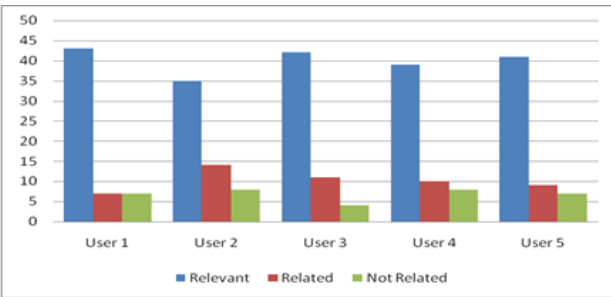
Fig. 2. Relevancy test for common keywords extracted from TF-IDF and Loglikelihood method